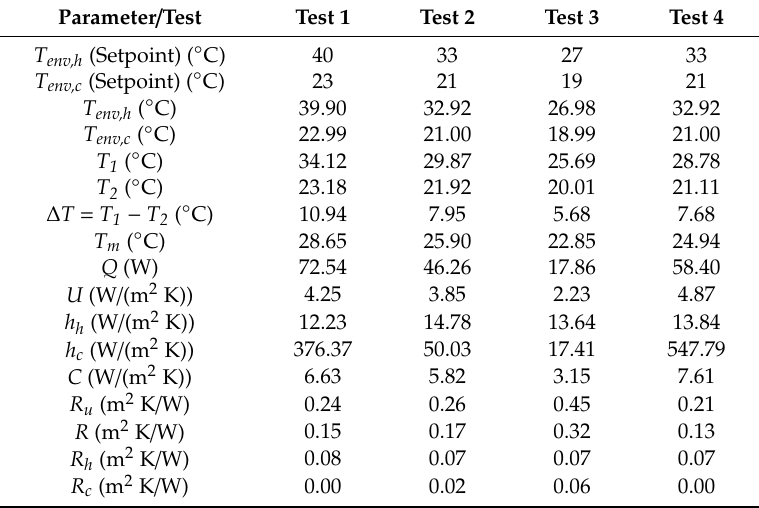
Table 4. Heat transfer quantities for Wall System